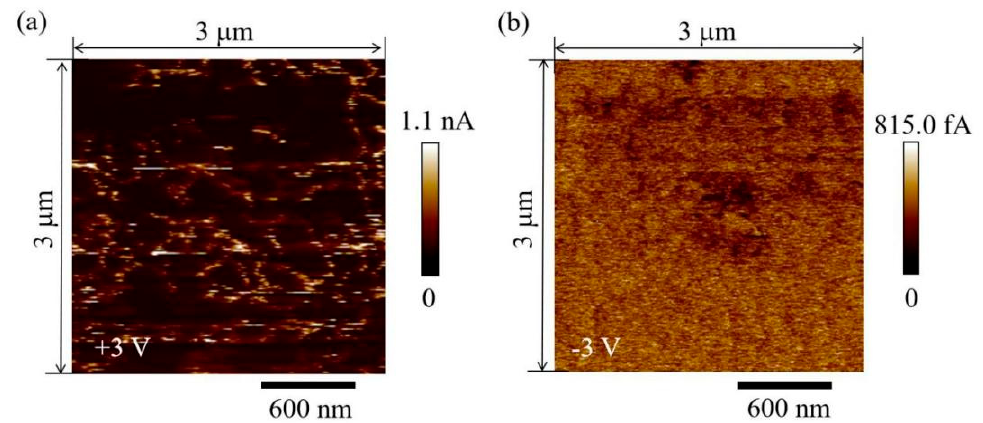
Figure 7. CAFM images of the ON state under ( a ) +3 V bias voltage and OFF state under ( b ) –3 V bias voltage. All image sizes are 3 µm × 3 µm.